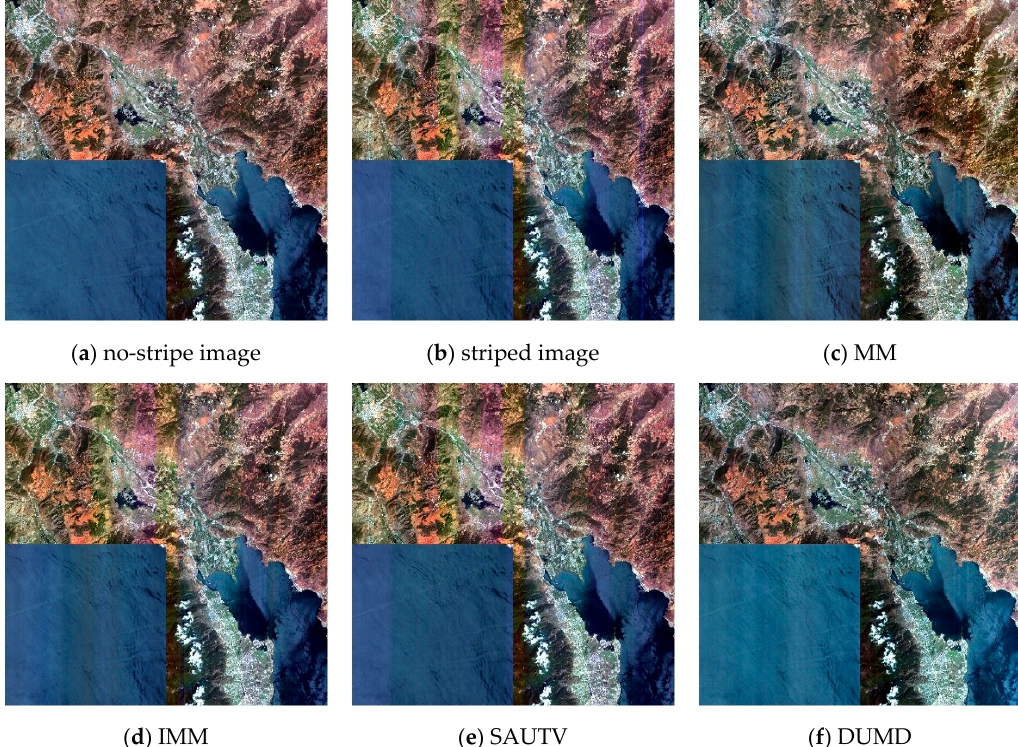
Figure 4. Destriping performance of Data 4 (Gaofen1-D, GF-1D). Where ( a ) is the no-stripe image, ( b ) is the striped image, ( c ) is the destriped image processed by MM, ( d ) is the destriped image processed by IMM, ( e ) is the destriped image processed by SAUTV, ( f ) is the destriped image processed by DUMD.